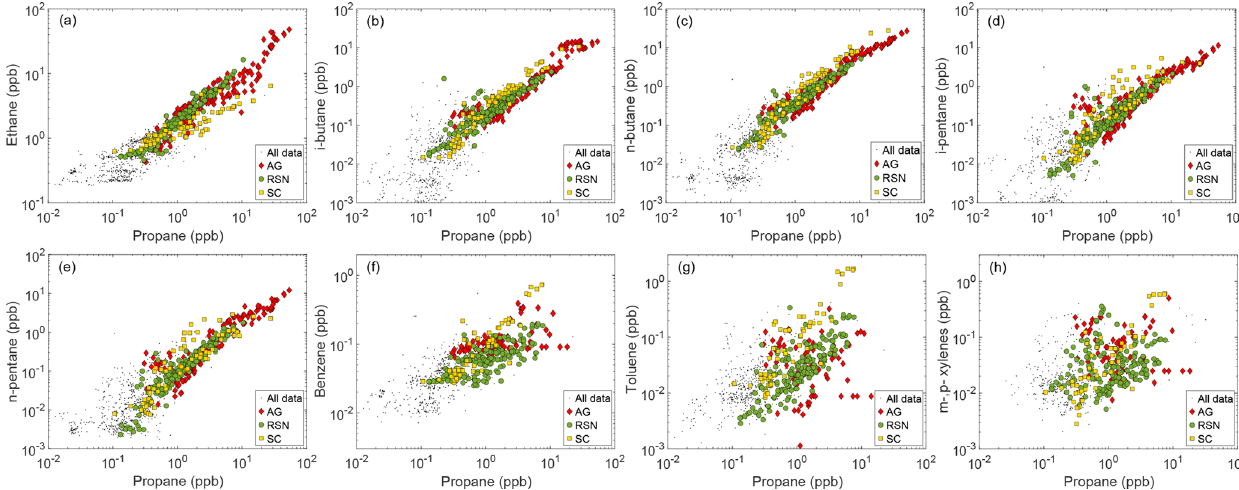
Figure 8. Correlations between propane and selected NMHCs for the areas of the Arabian Gulf (AG, red diamonds), Red Sea North (RSN, green circles) and Suez Canal and Gulf (SC, yellow